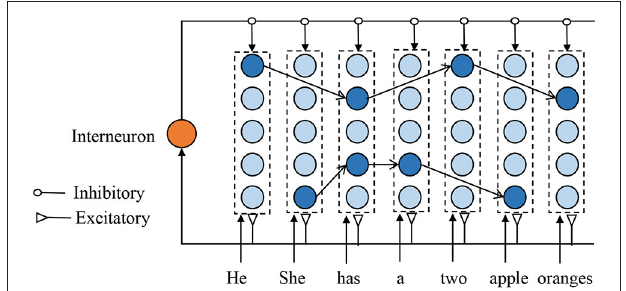
FIGURE 2 | Illustration of the proposed memory model structured with many mini-columns. Each column, comprises of spiking neurons, represent one memory item, and the firing neuron in each column depend on the previous input context. For clarity, the weak connections are not shown in this figure.